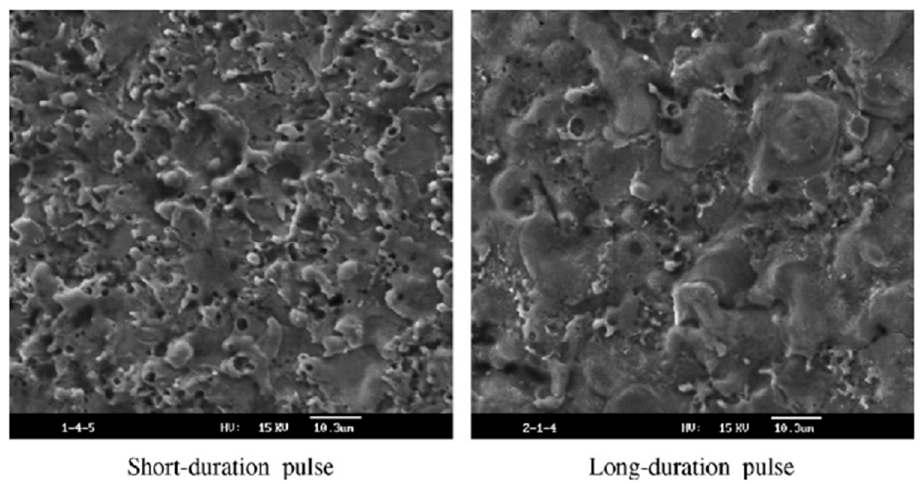
Figure 4. Surface morphologies of long- and short-duration pulses [202].